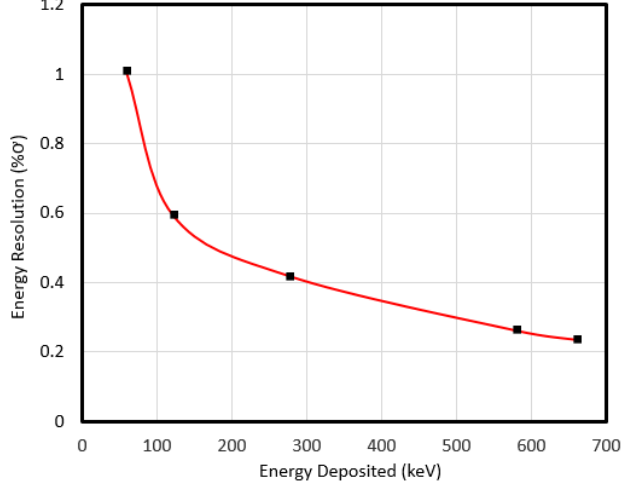
Fig. 8. Resolution range with the HPGe detector in the energy of incident